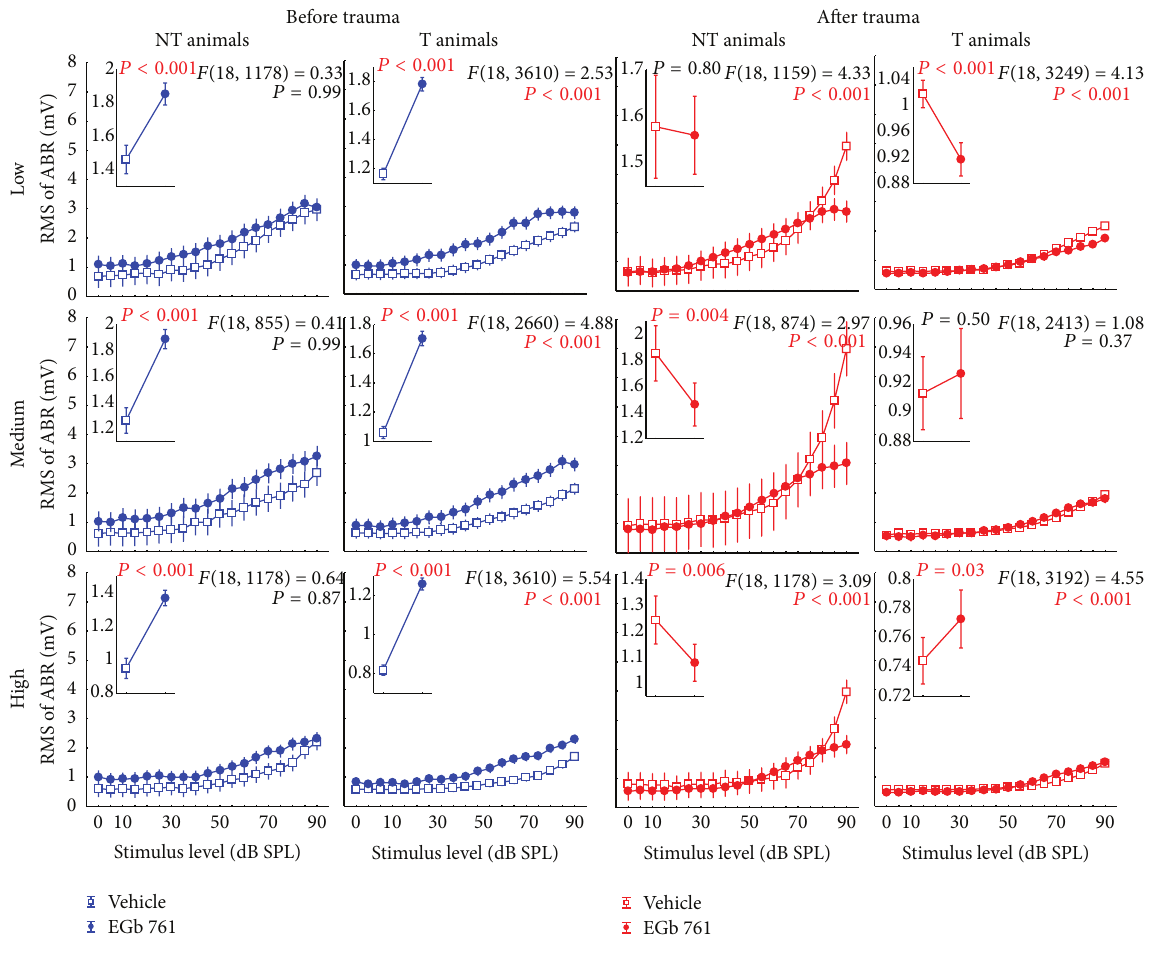
Figure 15: Replotted data of Figure 8, grouped according to the time of measurement (before versus after trauma) to allow for an easier comparison of vehicle versus EGB 761 treated animals. Note the consistent differences in the ABR amplitudes, especially for pretrauma in vehicle versus EGB 761 treated